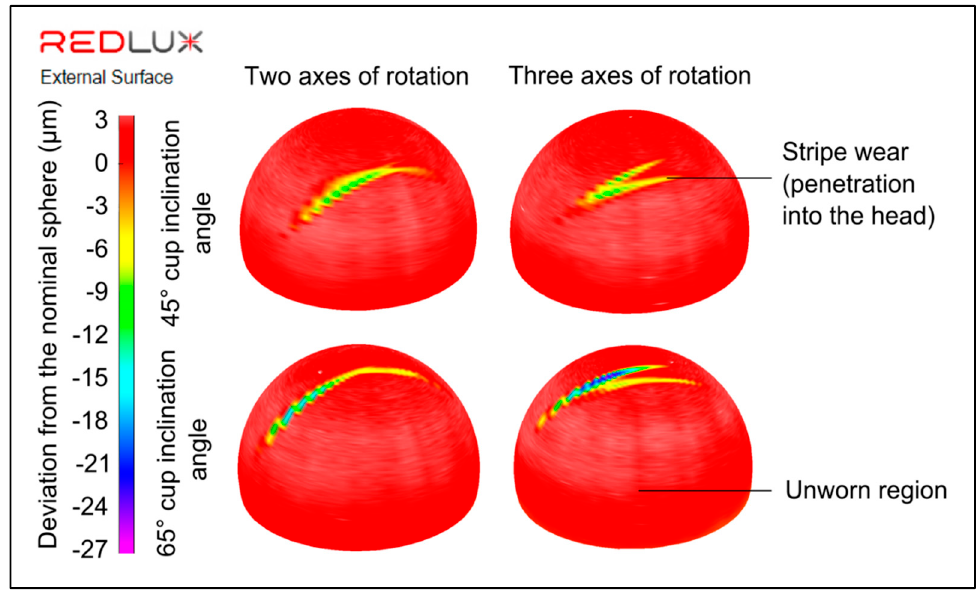
Figure 7. Wear rates (mean ± 95% confidence limits, n = 6) of 36 mm diameter BIOLOX ® delta ceramic-on-ceramic bearings under two axes and three axes of rotation conditions with 45 ◦ and 65 ◦ cup inclination angles and 4 mm of medial-lateral translational mismatch conditions. Ceramics 2019 , 2 FOR PEER REVIEW